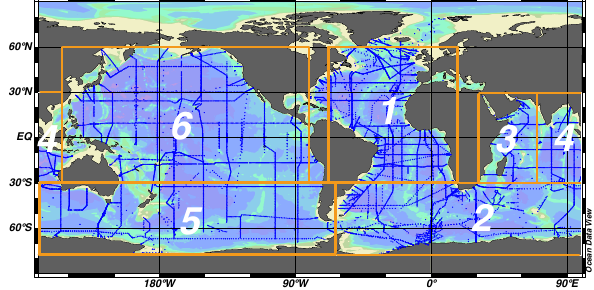
Fig. 3. Six major ocean regions used for testing the uncertainty range of the relationships of DIC and total alkalinity vs. 1 14 C (at >2000mw.d.). To the north, Region 3 ends in a monsoon-driven belt of high upwelling productivity off Somalia and southern Ara- bia. Region 5 includes the low-nutrient subtropical and subpolar southern Pacific